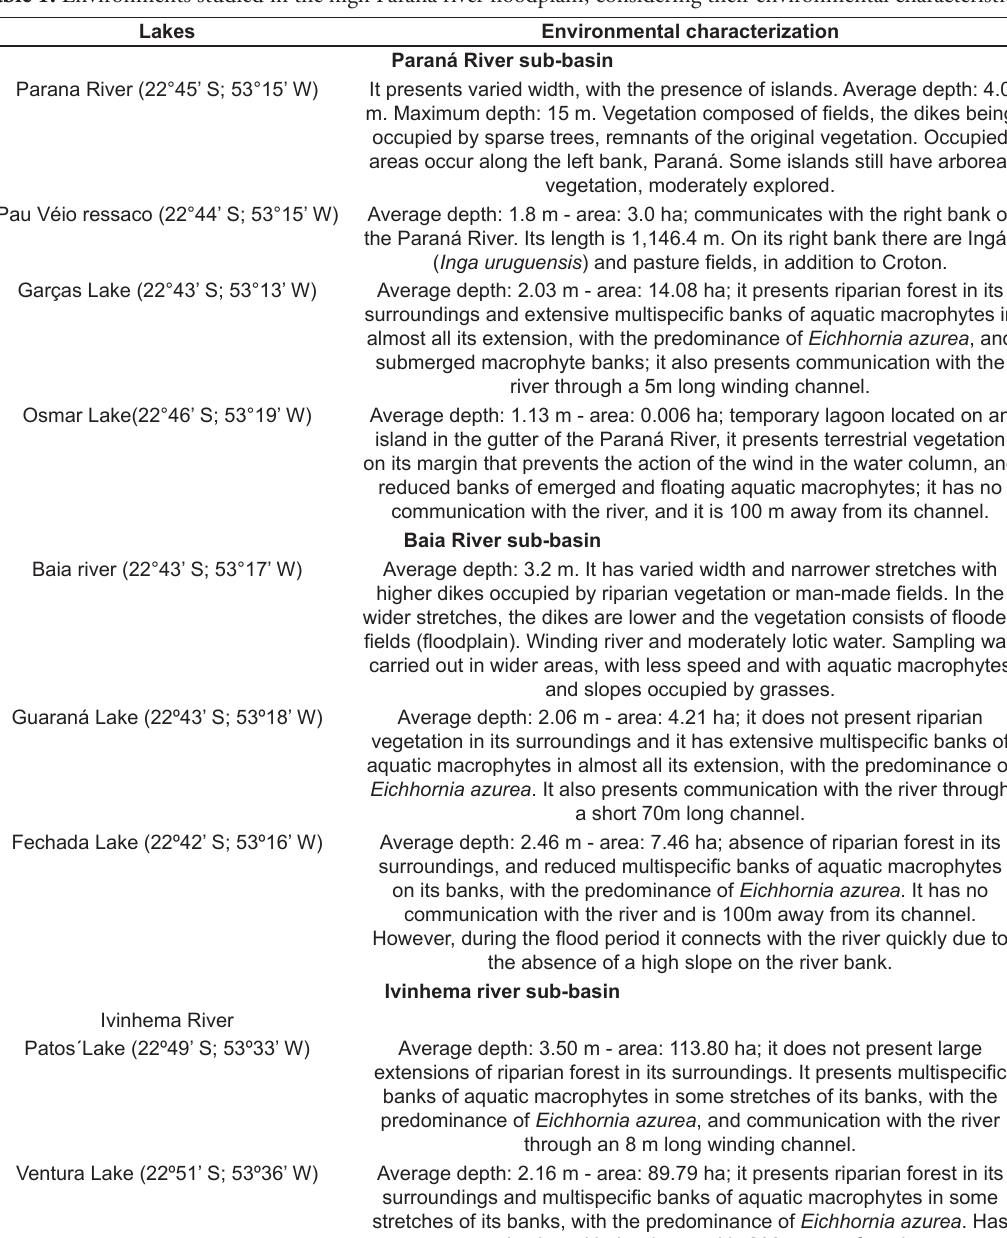
Table 1. Environments studied in the high Paraná river floodplain, considering their environmental